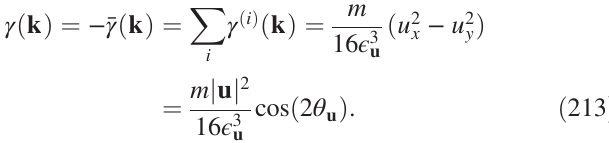
FIG. 3. The anisotropic viscosities γ of the mass m ∈ ½ − 4 ; 4 (cid:2) for the C 2 symmetric Chern insulator. The hoppings are fixed to be t ¼ 1 . 5 and t ¼ r ¼ 1 , while the lattice constant is again a ¼ 1 . We see that all viscosities are odd in m .